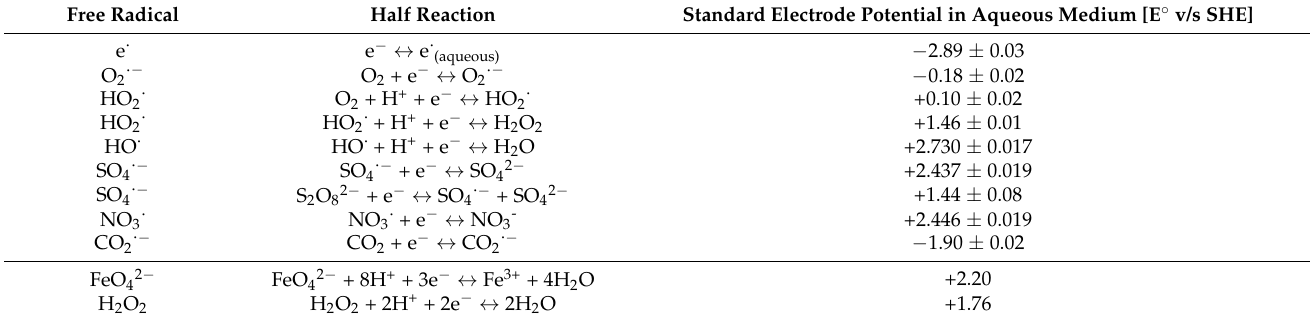
Table 1. Standard electrode potentials in aqueous medium (E ◦ v/s SHE) of the most common free radicals and common oxidants. SHE: standard hydrogen electrode [26,27]. Free Radical Half